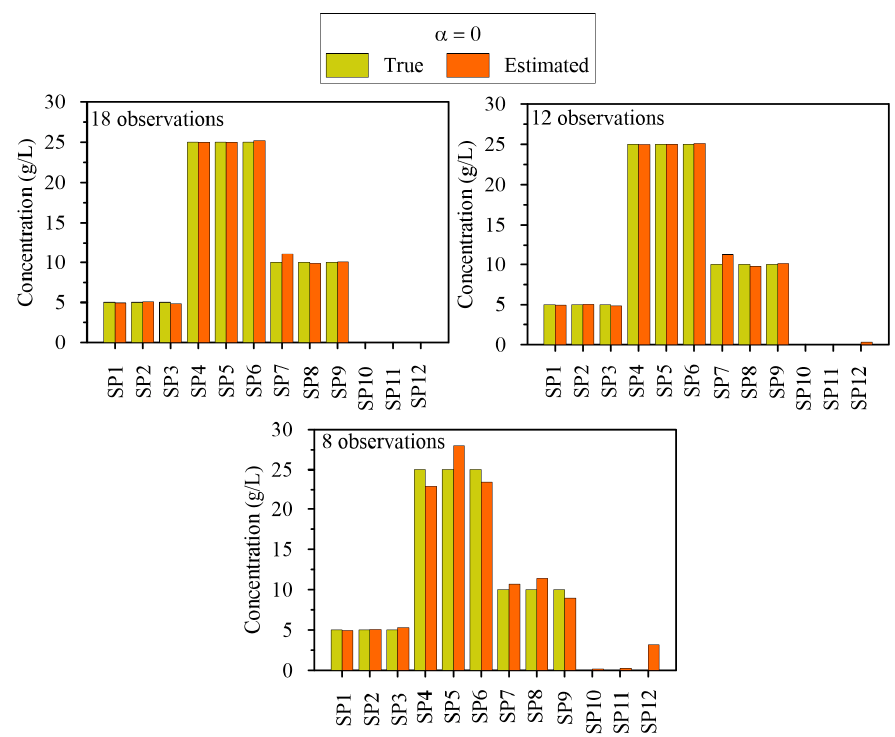
Figure 14. Source release histories in error-free data condition ( α = 0) with 18, 12 and 8 observed concentrations data. Water 2020 , 12 , x FOR PEER REVIEW